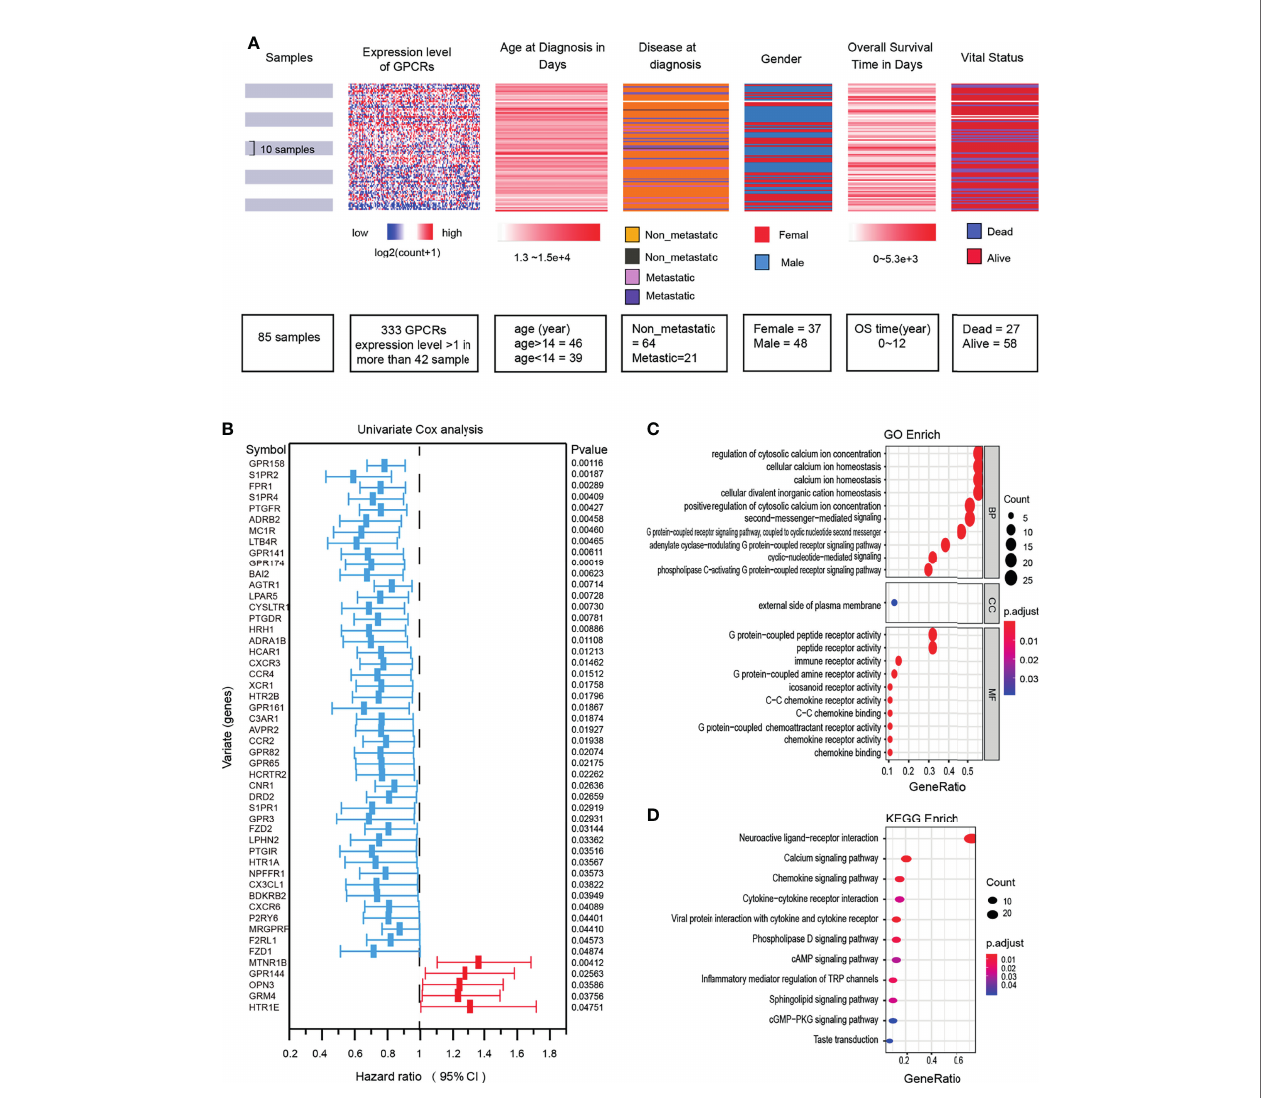
FIGURE 2 | (A) OS clinical information and expression levels of GPCRs. (B) The forest plot shows the results of univariate Cox regression analysis, there are 50 GPCRs related to OS risk. Hazard ratio <1 indicates the protection factor (blue), Hazard ratio >1 indicates the risk factor (red), CI, Con fi dence interval. (C) Functional enrichment analysis of GPCRs in GO terms. (D) Signaling pathway enrichment analysis of GPCRs in the